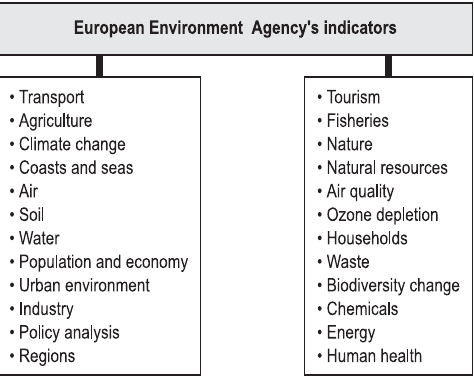
Fig. 4. European Environment Agency’s classifi cation of Sustainable development